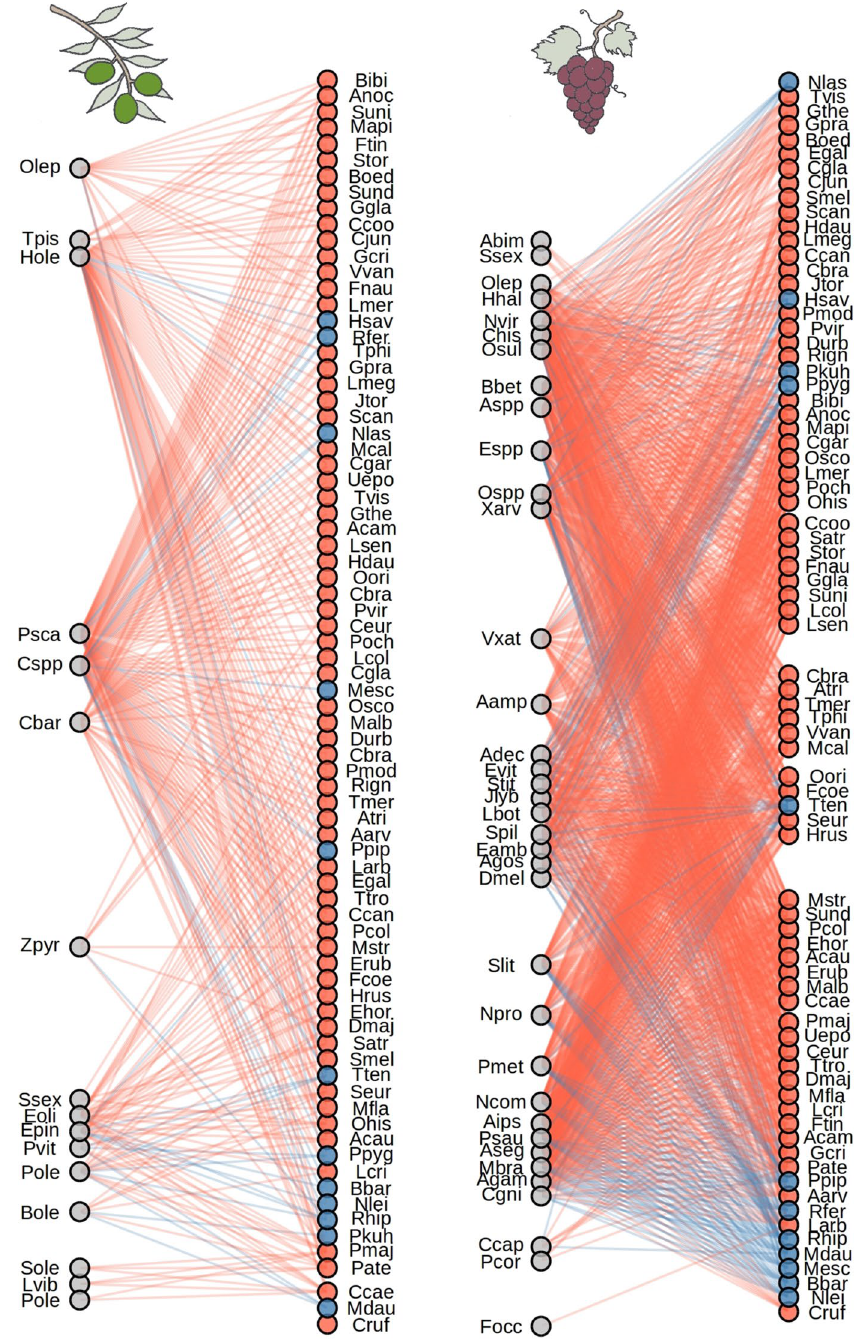
Figure 2. Trophic interaction links between vertebrates and olive (left panel) and grape (right panel) pests. Grey circles represent pest species of each crop, whereas red and blue circles represent bird and bat species, respectively. Trophic interactions between pests and vertebrates were obtained through a literature review (Supplementary Table S1). Identities of both vertebrate and pest species were simplified by using four-letter